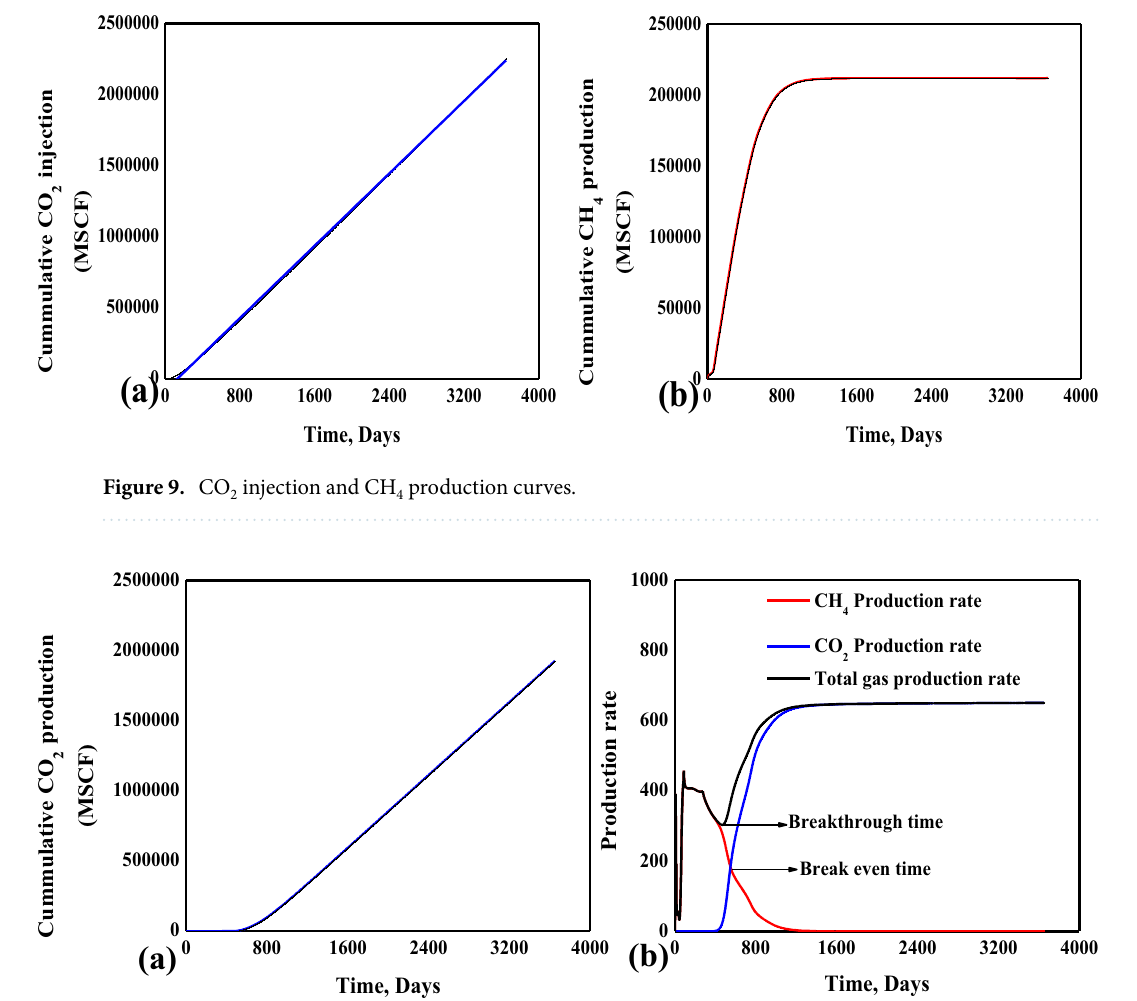
Figure 10. Breakthrough time and production